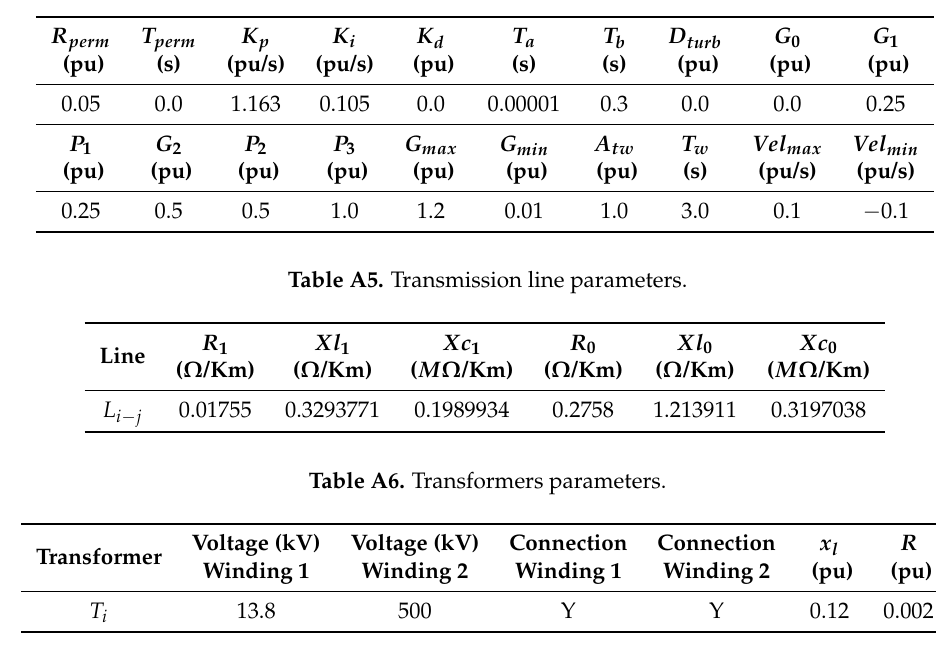
Table A4. Governor parameters (type PIDGOV).